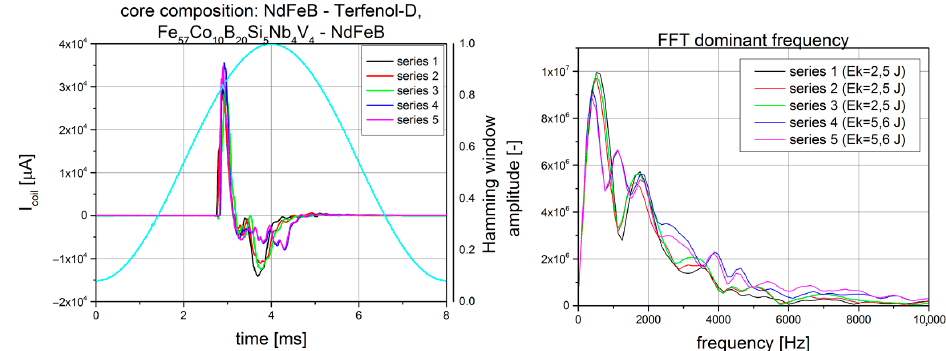
Figure 7. Example of the coil current measured for solid Terfenol-D with Fe 57 Co 10 B 20 Si 5 Nb 4 V 4 alloy pieces, as well as its FFT.